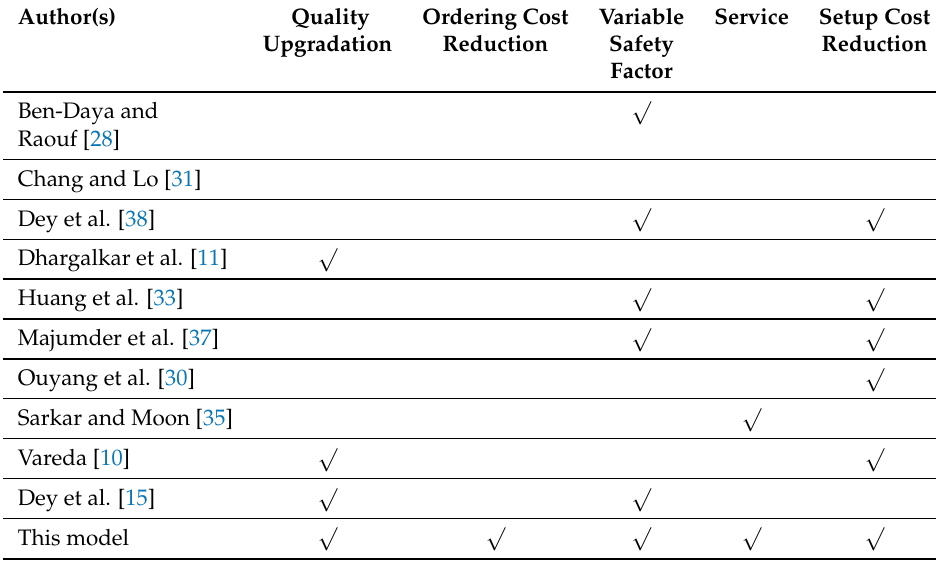
Table 1. Research gaps and contributions of previous